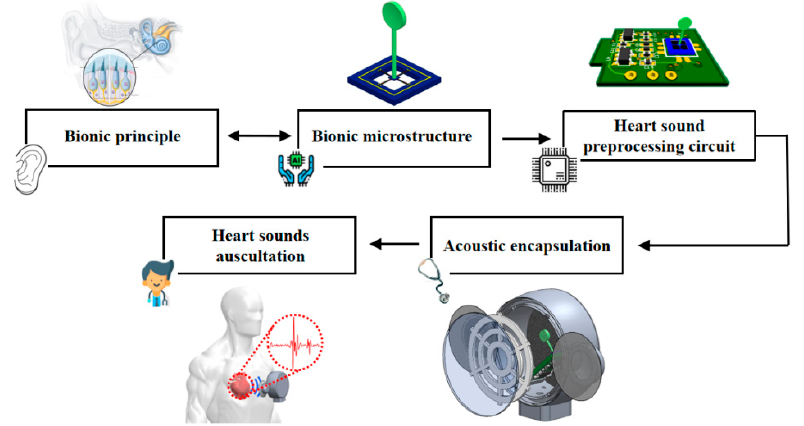
Figure 8. Overall system design block diagram.